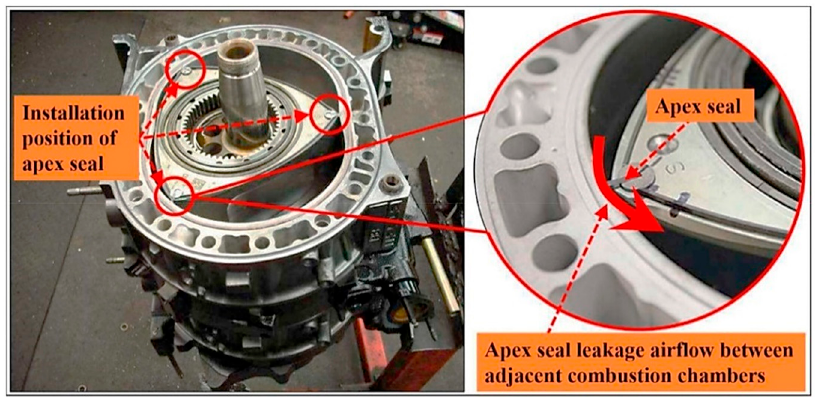
Figure 8. Apex seal leakage between adjacent combustion chambers (Fan et al. [74]).